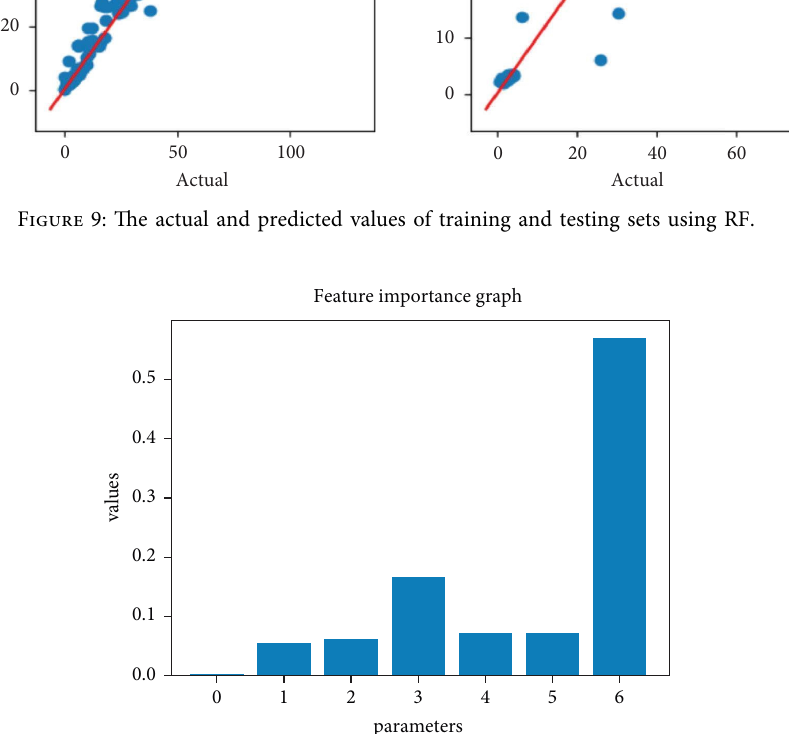
Figure 10: Feature importance graph. 0 � soil classifcation, 1 � liquid limit, 2 � plastic limit, 3 � plasticity index, 4 � maximum dry density, 5 � optimum moisture content, and 6 �